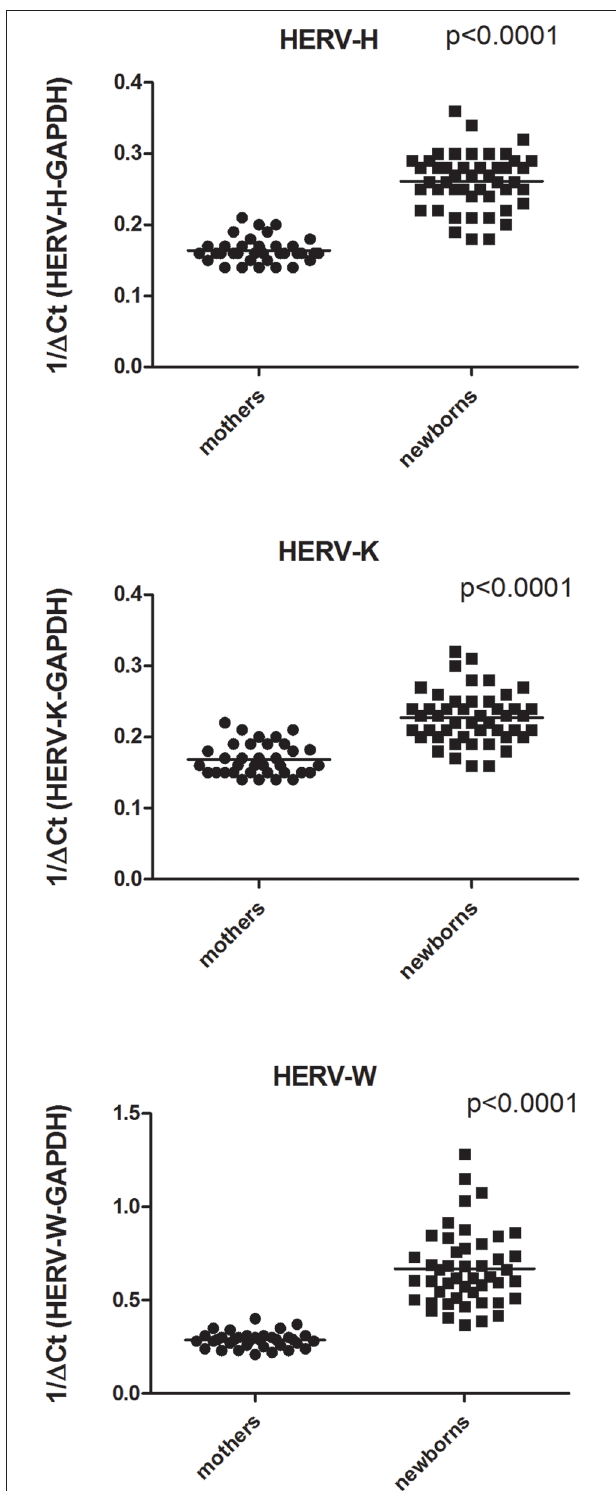
FIGURE 2 | Transcription levels of pol genes of HERV-H, HERV-K, and HERV-W in mononuclear cells from peripheral blood of parturients and from cord blood of newborns collected after an at term pregnancy and vaginal delivery. Data are represented as black dot. Relative pol levels were assessed by real-time PCR and